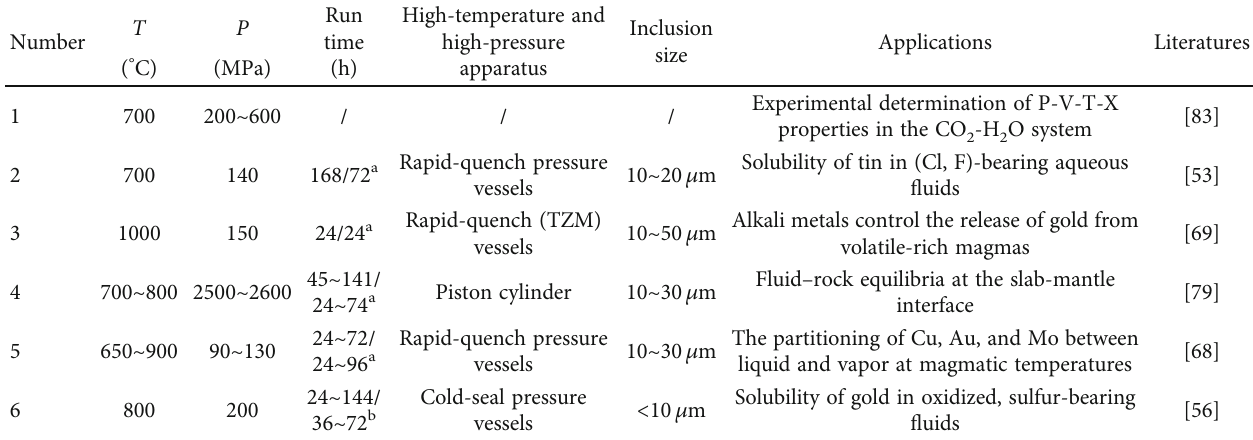
Table 4: Some typical applications of the in situ fracturing FIS